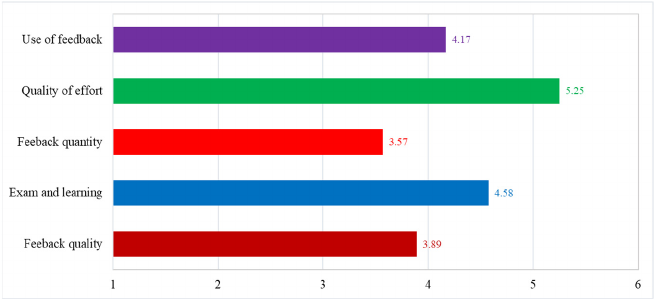
Figure 1. Students’ learning experience in Mathematics 1. Note. 1—strongly disagree, 2—disagree, 3—slightly disagree, 4—slightly agree, 5—agree, and 6—strongly